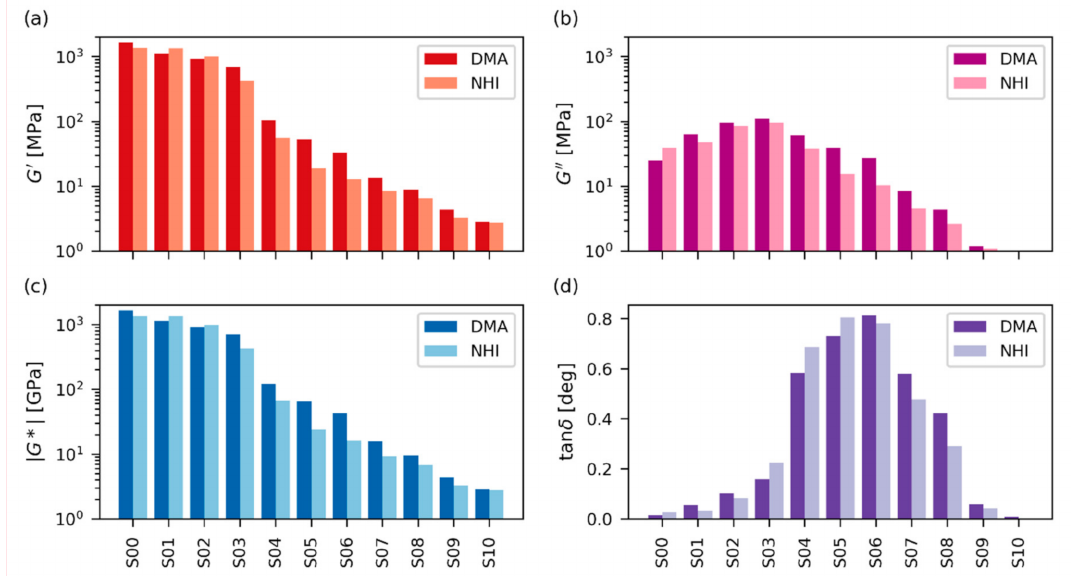
Figure 7. Results of dynamic experiments: macroscale dynamic mechanical analysis (DMA) and dynamic nanoindentation experiments (NHI): ( a ) storage modulus, G (cid:48) , ( b ) loss modulus, G ”, ( c ) absolute value of complex modulus | G * | , and ( d ) damping factor, tan δ